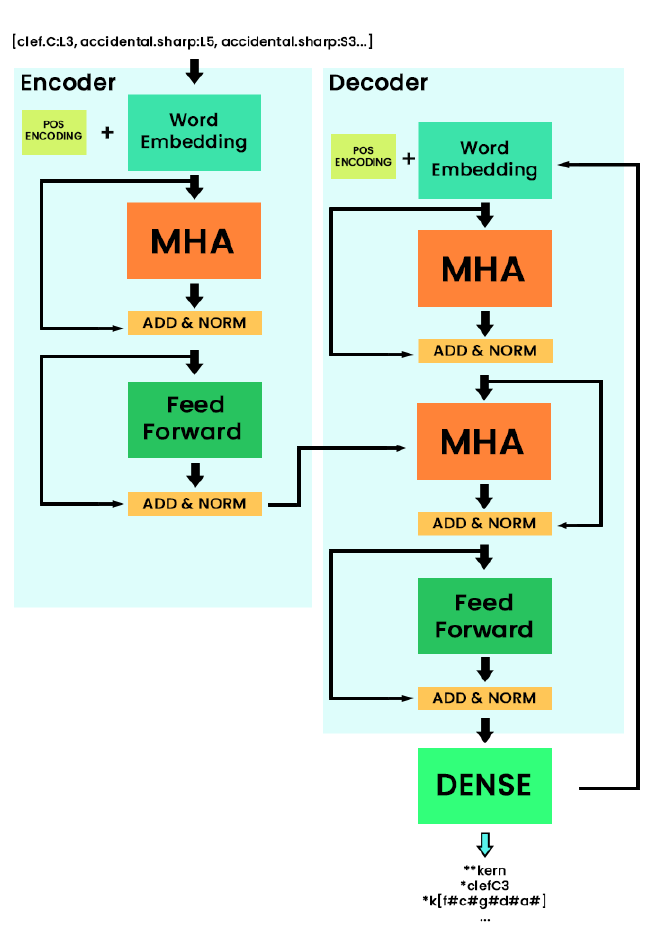
Figure 4. The proposed transformer neural architecture, which was adapted from [26]. The MHA blocks are the multi-headed attention mechanisms described in this article and in the reference paper, and the POS ENCODING blocks refer to the mentioned positional encoding functions which are computed with the respective